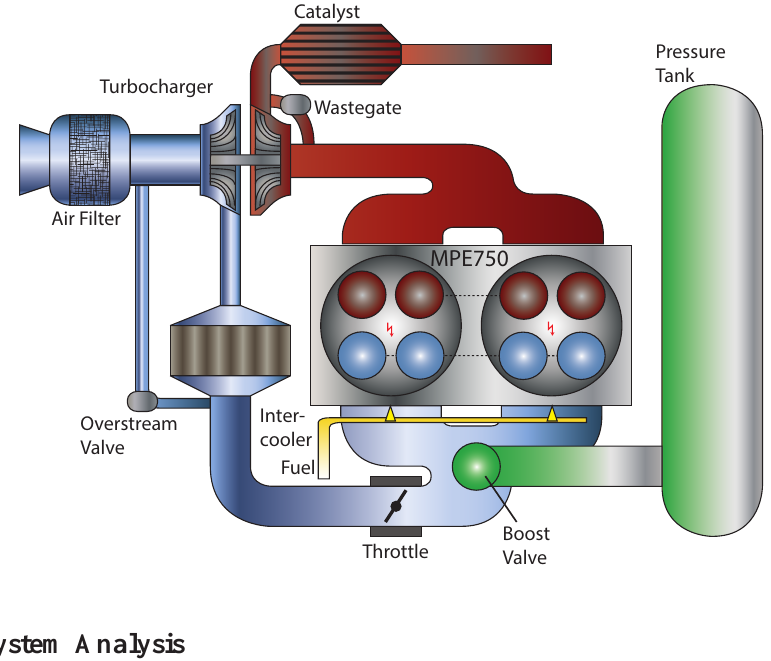
Figure 1. System structure of a turbocharged SI engine with intake manifold boosting. A pressure tank is connected to the intake manifold.